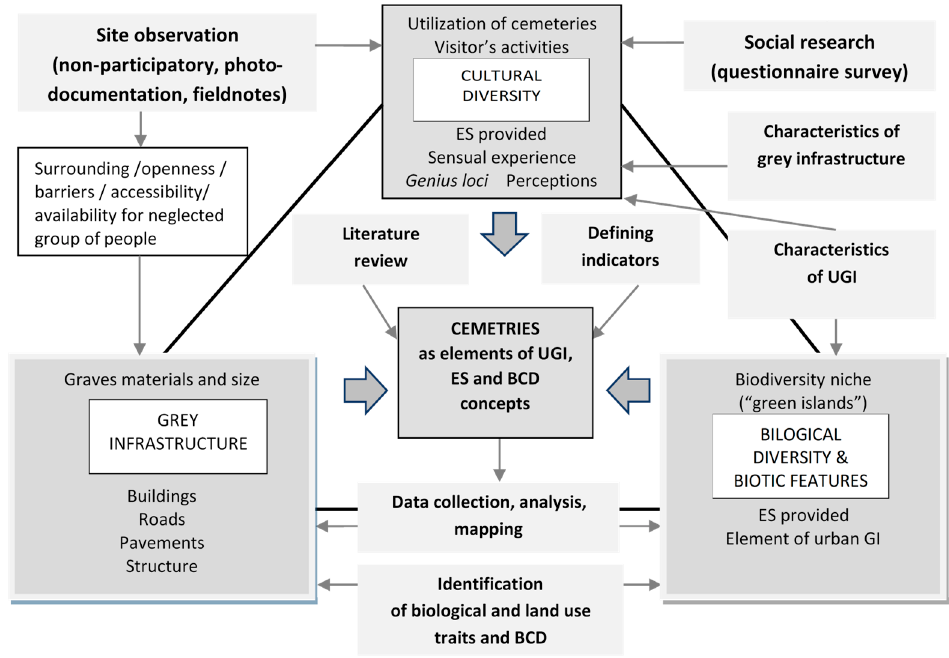
Figure 1. Research framework. Source: authors .